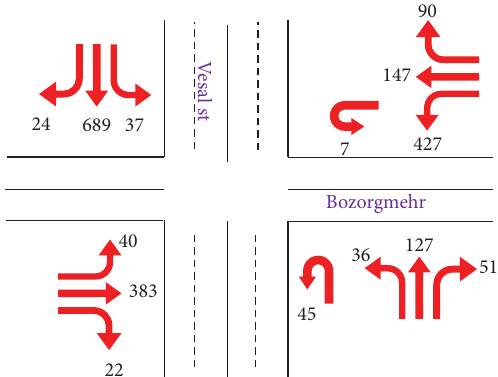
Figure 1: Vesal-Bozorgmehr intersection with passing volumes at the peak hour (vehicle per hour).